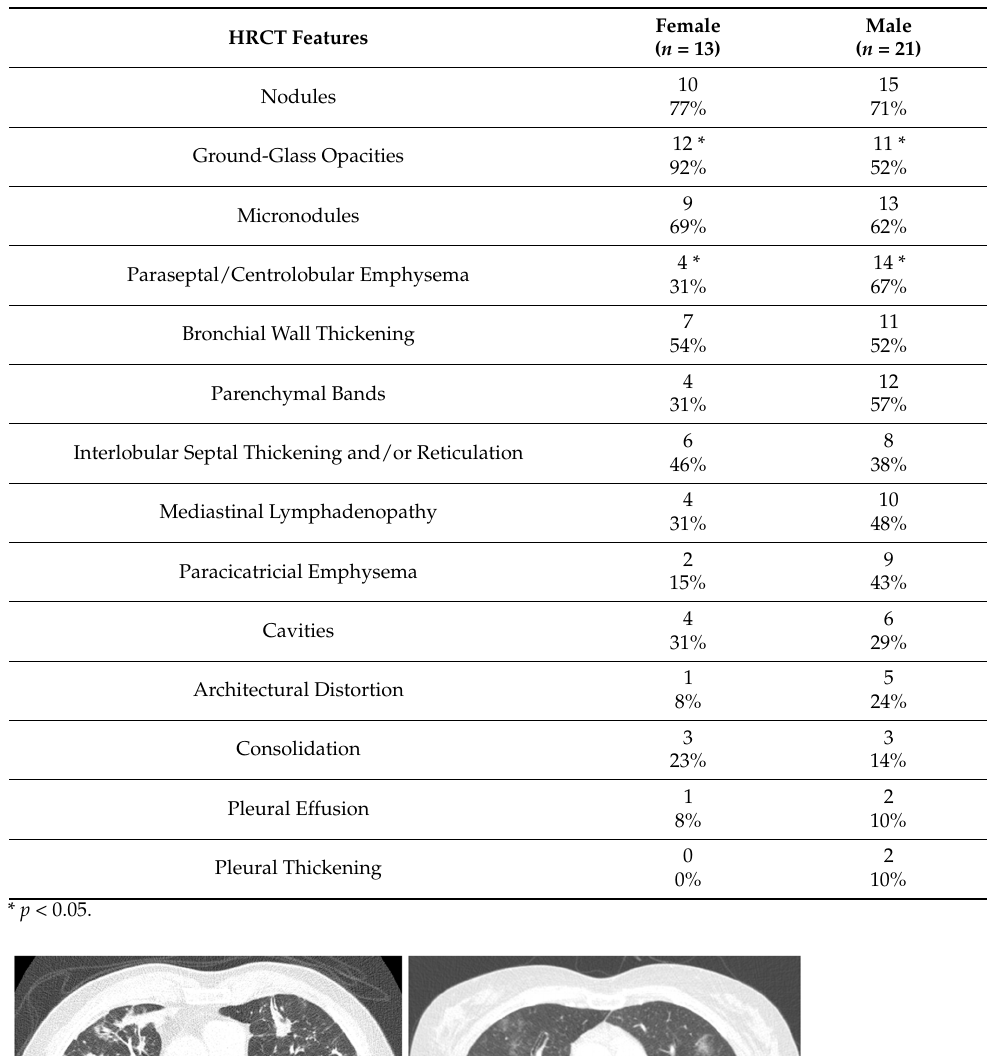
Table 4. Abnormalities of CF women’s and men’s pulmonary HRCTs taken before treatment.